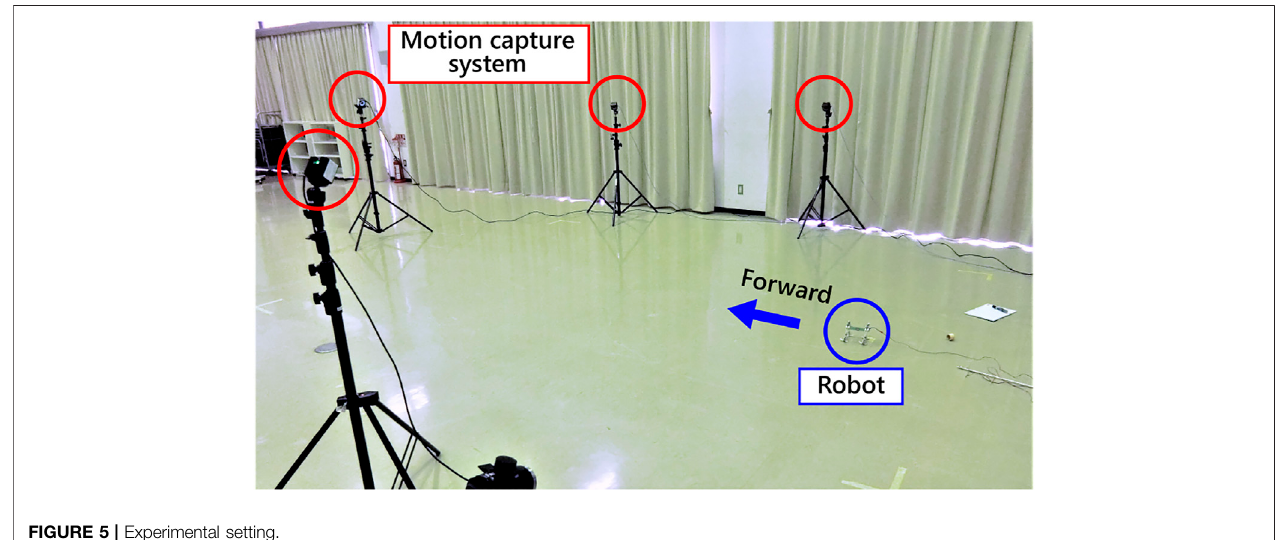
FIGURE 5 | Experimental setting.